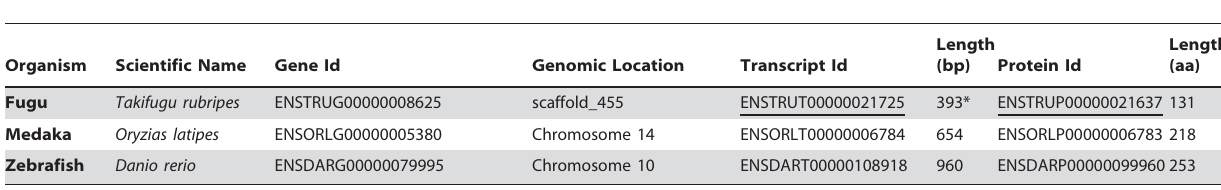
Table 4. List of OVOL3b genes from fish genomes, identified from Ensembl database release 58 (May 2010).